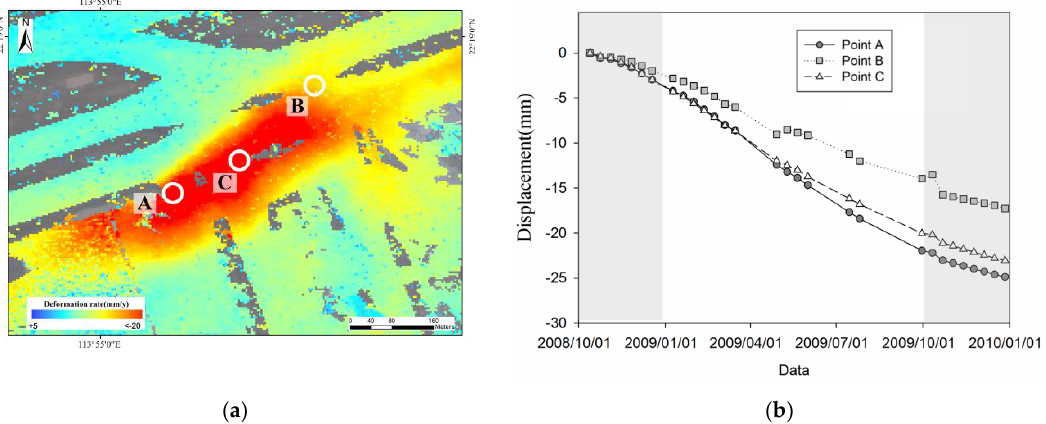
Figure 7. DSI results of the northern runway near the Y-shaped terminal building from TerraSAR-X Spotlight images, the location of which is represented by the white rectangle (zone 1) in Figure 6b. ( a ) Linear deformation rate superimposed on Google Earth image and ( b ) displacement time series of points A, B and C in Figure 7a. Grey areas approximately indicate the winter periods from Oct. to Dec. of 2008 and 2009.